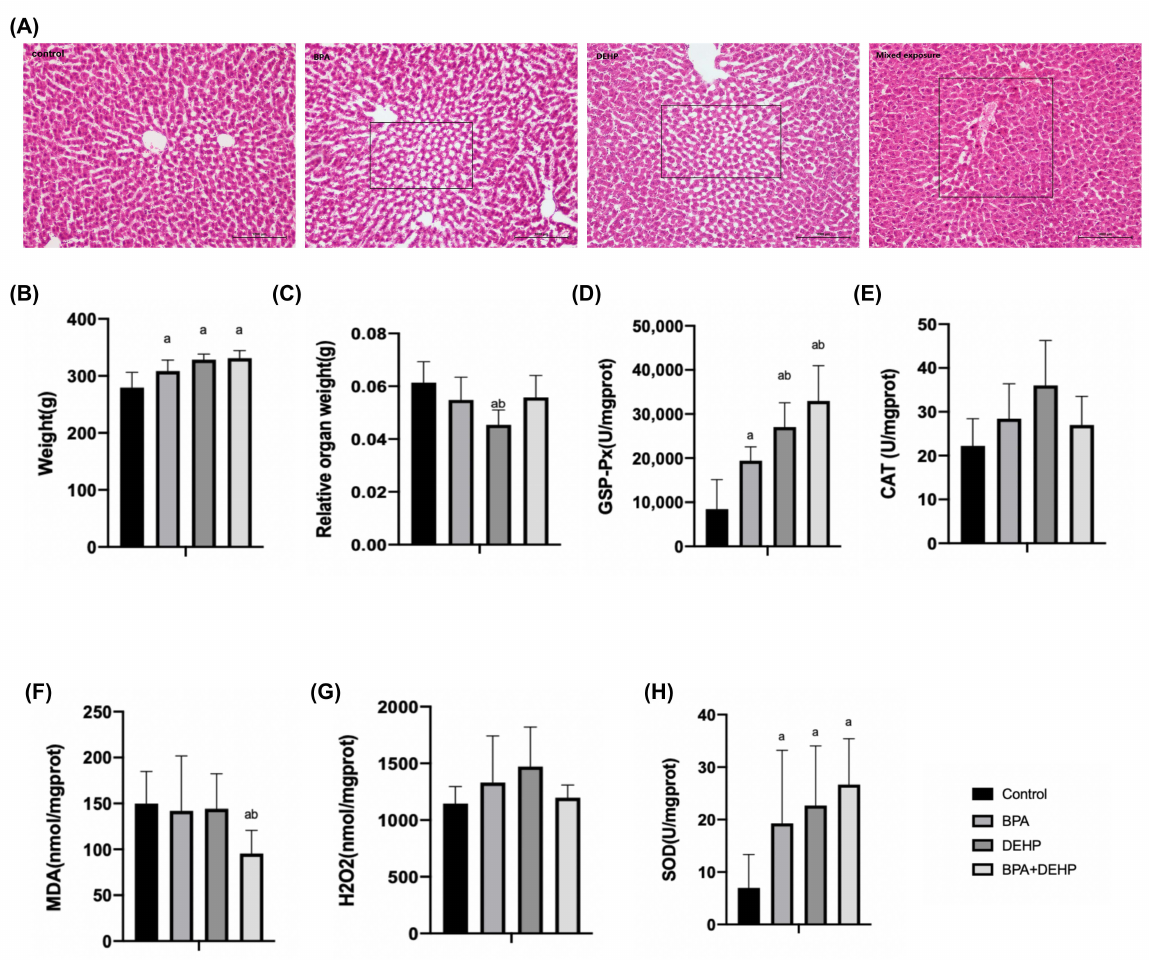
Figure 4. Histopathological changes of pregnant females with haematoxylin and eosin ( A ). Body weight gain of pregnant females exposed to BPA, DEHP and BPA+DEHP ( B ). Relative organ weight of pregnant females exposed to BPA, DEHP and BPA+DEHP ( C ). GSH-PX activity changes of pregnant females exposed to BPA, DEHP and BPA+DEHP ( D ). CAT activity changes of pregnant females exposed to BPA, DEHP and BPA+DEHP ( E ). H 2 O 2 assay of pregnant females exposed to BPA, DEHP and BPA+DEHP ( F ). MDA assay of pregnant females exposed to BPA, DEHP and BPA+DEHP ( G ). Superoxide dismutase activity of pregnant females exposed to BPA, DEHP and BPA+DEHP ( H ). Data are presented as means ± SEM. [Note]: “a”: compared with control, “b”: compared with BPA group, p < 0.05, n = 6. Scale bar = 1000 µ